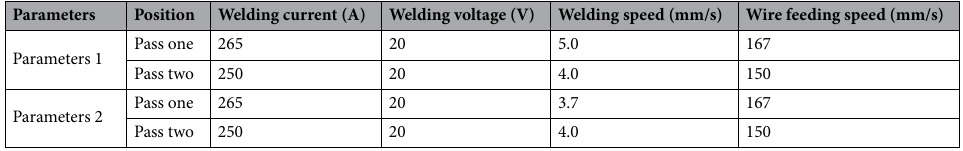
Table 1. Parameters for CMT welding Q235 carbon